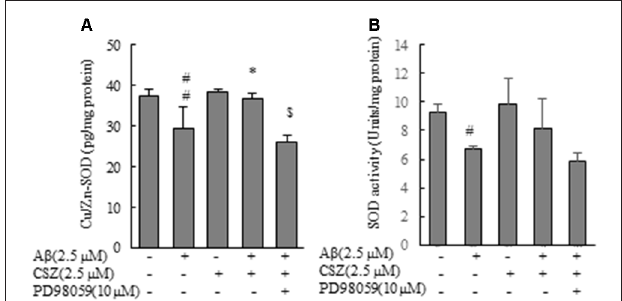
FIGURE 7 | Effects of CSZ on Cu/Zn-Superoxide Dismutase (SOD) content, SOD activity in A β -stimulated SH-SY5Y cells. (A) Cu/Zn-SOD isozyme contents, (B) SOD activities in the cell lysate were determined. The effect of a MEK1/2 or p38 MAPK inhibitor was also examined. Values are expressed as mean + SEM. # Statistical significance compared vs. control cells ( p < 0.05). ## Statistical significance compared vs. control cells ( p < 0.01). ∗ Statistical significance compared vs. 2.5 µ M A β -treated cells ( p < 0.01). $ Statistical significance compared vs. 2.5 µ M A β + CSZ-treated cells ( p <